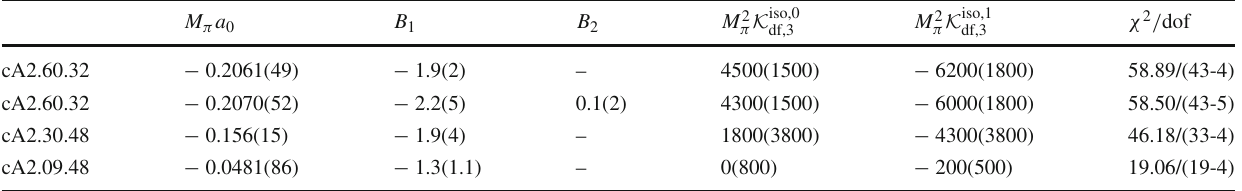
Table 6 Two- and three-pion fits using the Adler-zero form ( z 2 = M 2 π , fixed). Since we only include s -wave interactions, we use two-pion levels in the A 1 irrep, and all irreps for three-pions. Recall that 1 / B 0 = M π a